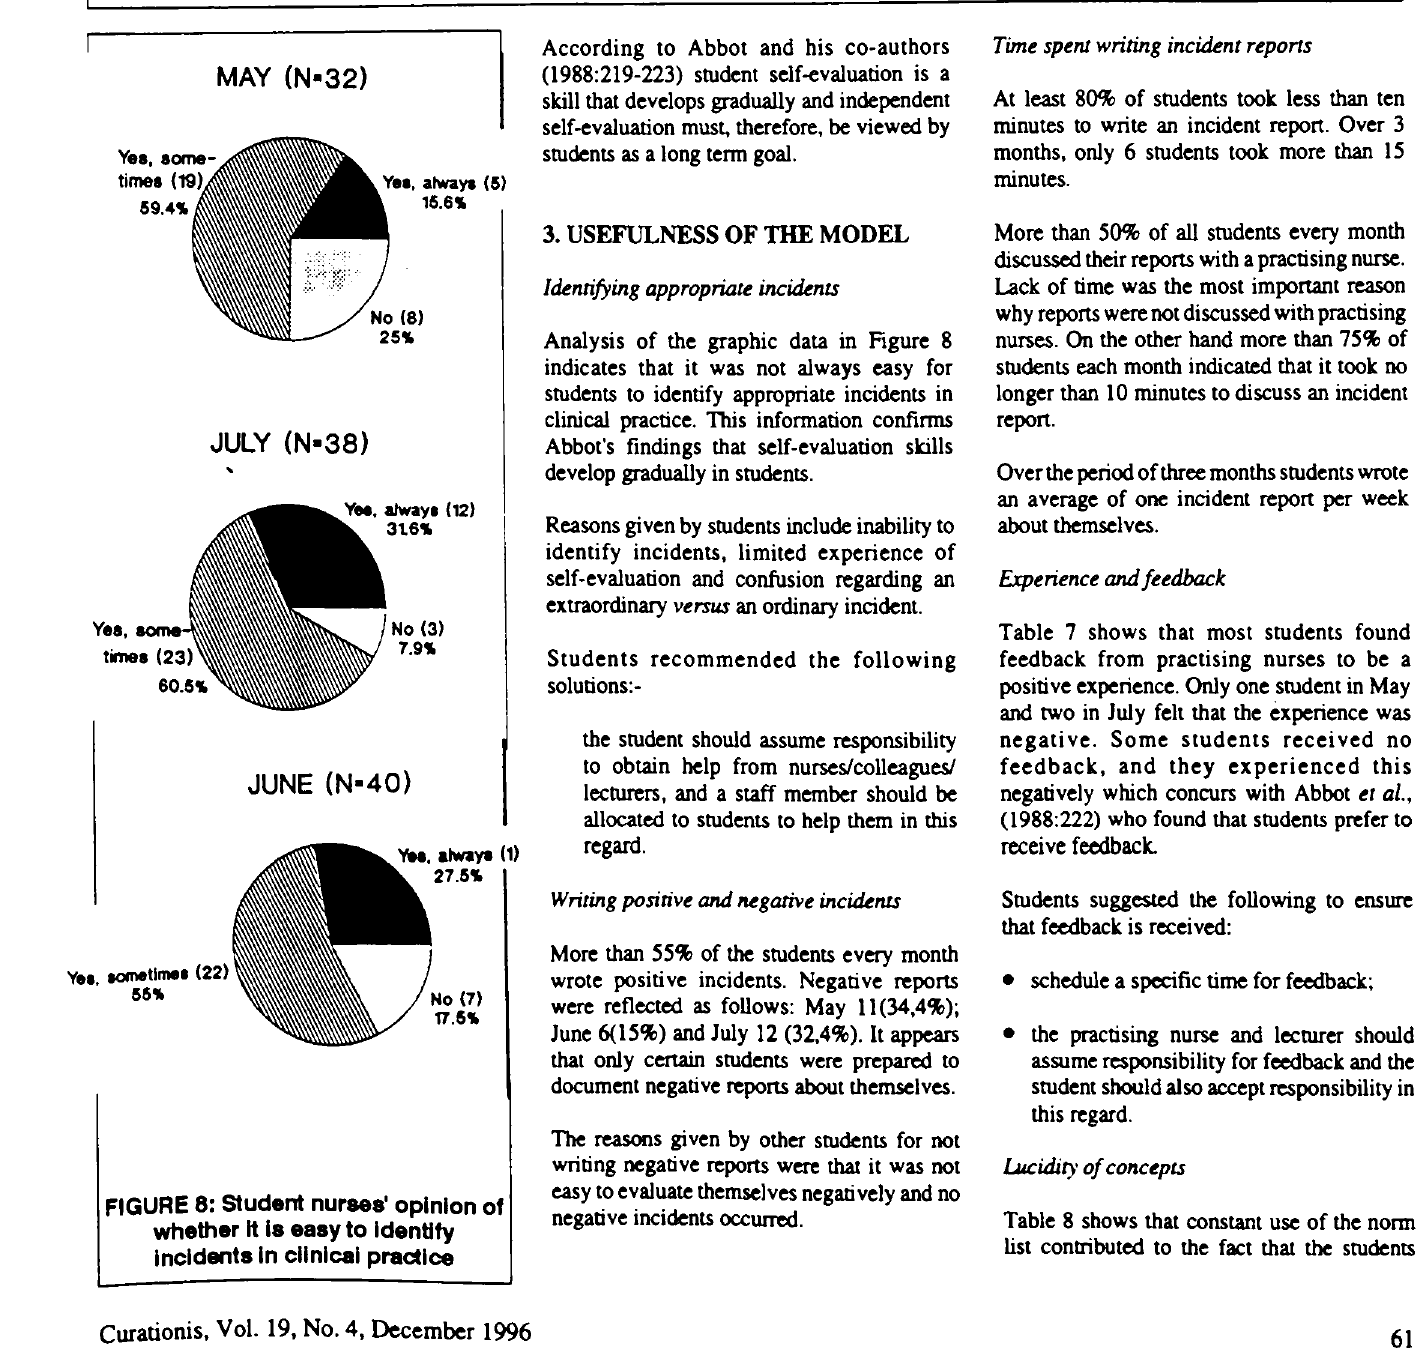
FIGURE 8: Student nurses' opinion of wtiether it is easy to identify incidents in ciinicai